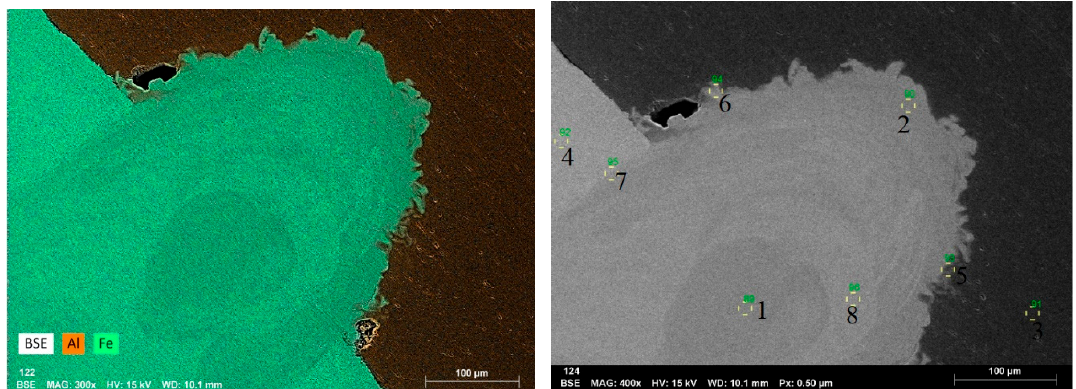
Figure 15. Back-scattered electron detector (BSE) images with elemental composition mapping using Energy-dispersive X-ray spectroscopy (EDS). Table 5. Elemental composition mapping (normalized mass concentration [%]).